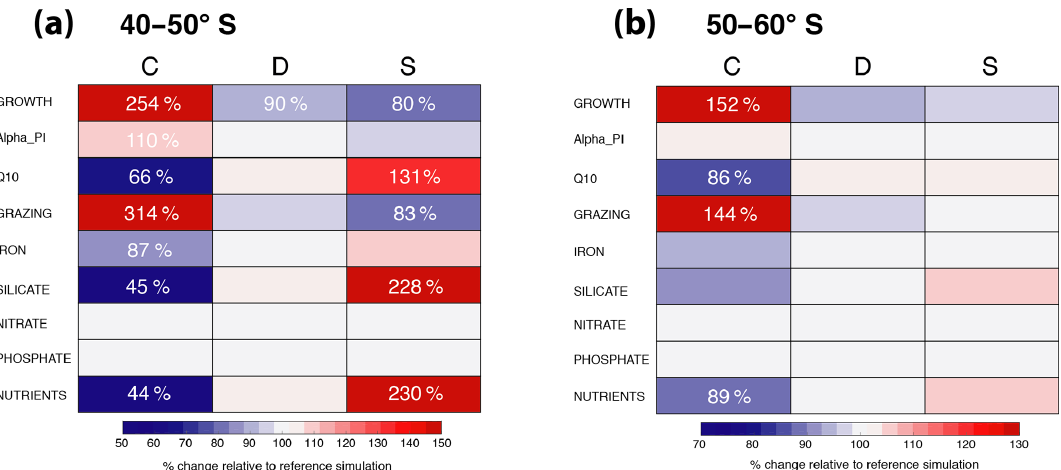
Figure 7. Relative change in annual mean surface chlorophyll biomass of coccolithophores (C), diatoms (D), and small phytoplankton (SP) for (a) 40–50 ◦ S and (b) 50–60 ◦ S for simulations assessing coccolithophore parameter sensitivities (see Table 2). Numbers of relative change are printed if change is larger than ±